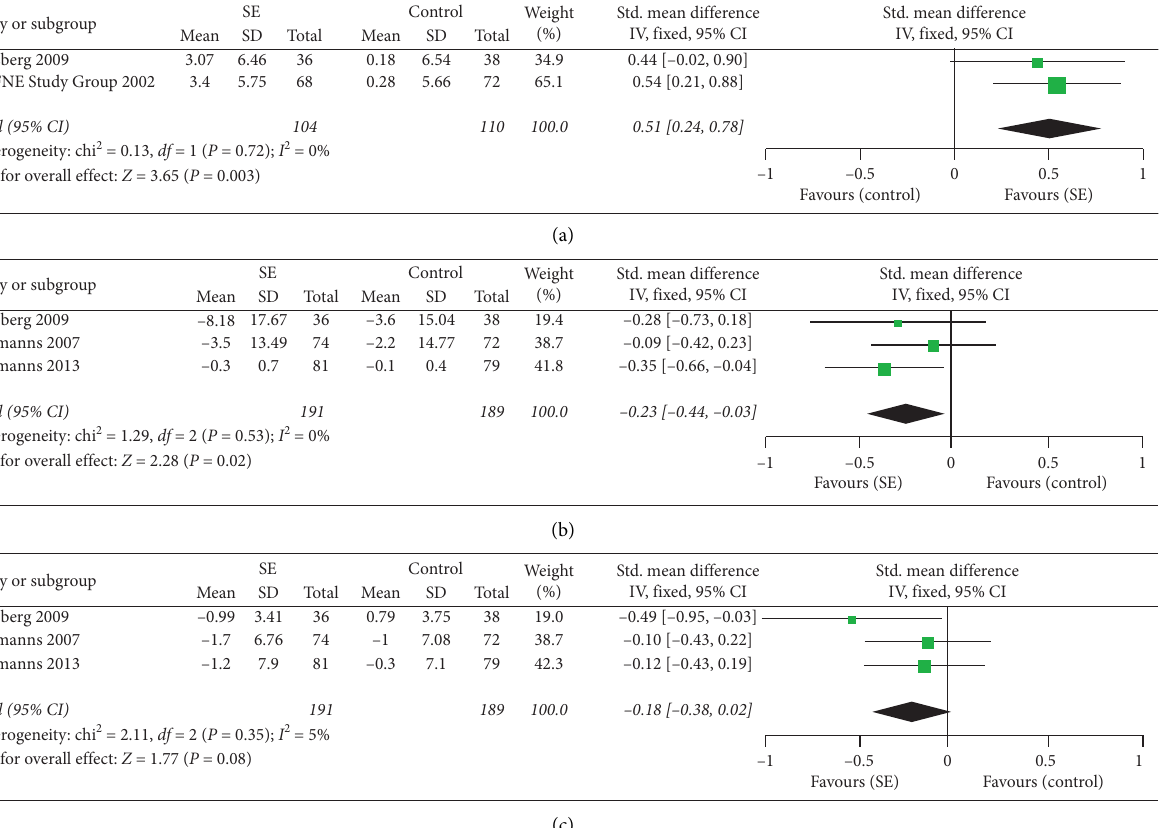
Figure 6: Forest plots showing effect size in changes in outcomes after intervention in adult patients with T1DM. (a) Well-being, (b) psychological distress, and (c) depression.